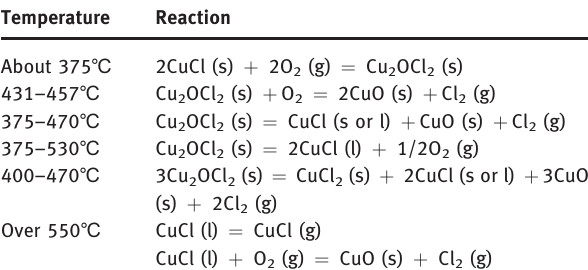
Table 1: The main chemical reactions of Cu – Cl – O system.